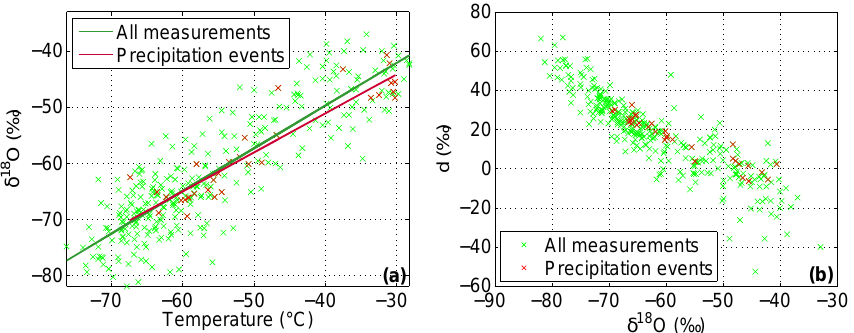
Figure 4. (a) Daily measurements of δ 18 O plotted against 2m temperature; the measurements during precipitation events are marked by red crosses. Linear fits for all measurements and for the days with a measured precipitation event are represented by a green and a red line. (b) Daily measurements of deuterium excess plotted against δ 18